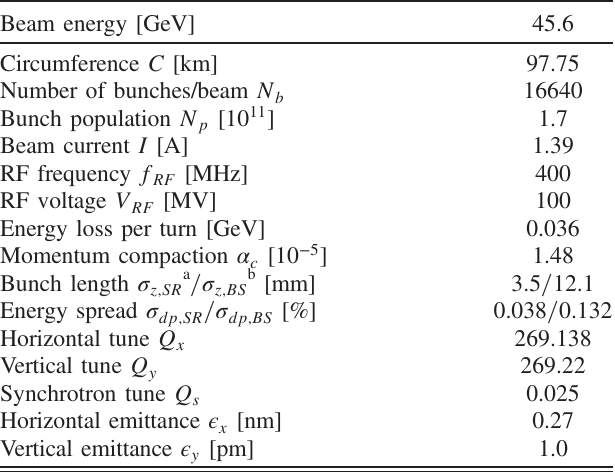
TABLE I. FCC-ee baseline beam parameters used for beam dynamics and electron cloud